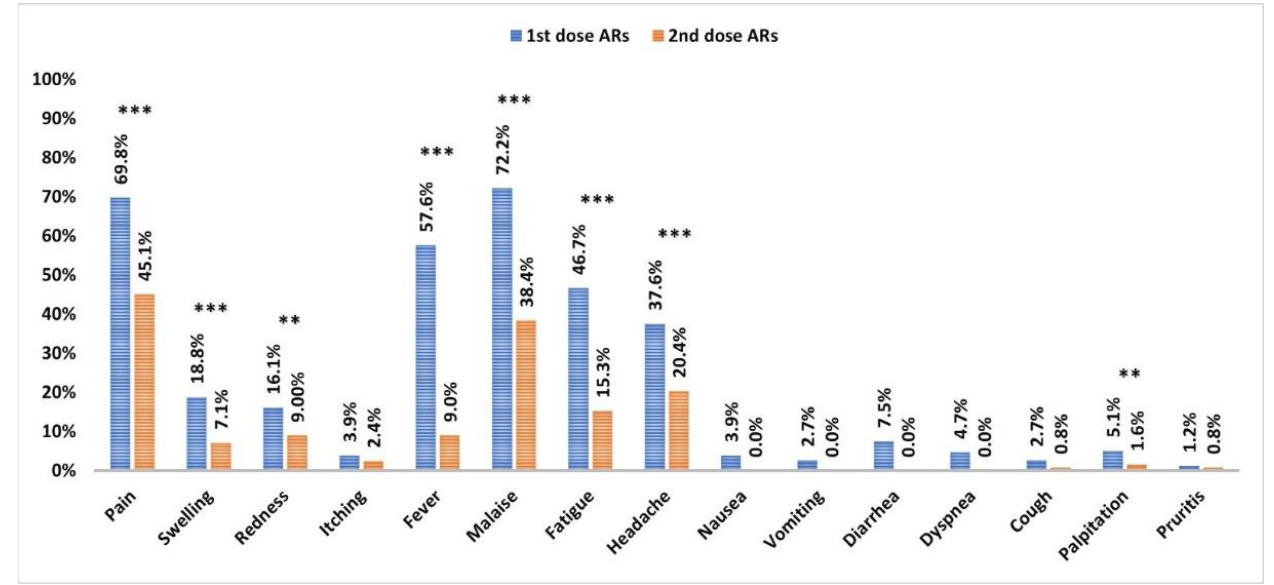
Figure 3. Frequency of local and systemic ARs to vaccine after administration of the 1st and 2nd doses. Data were analyzed by McNemar Test, and significant differences were defined as *** p < 0.001 and ** p < 0.01. AR; adverse reactions.